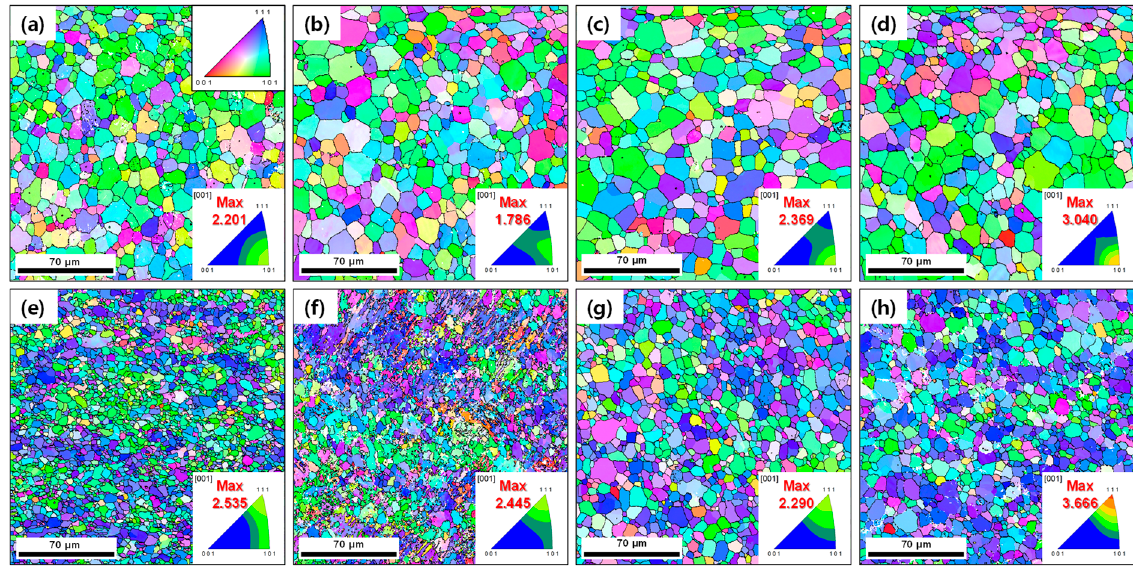
Figure 3. The IPF maps for the AR samples ( a ) annealed for 5 min at 873 K, ( b ) annealed for 5 min at 873 K and then aged at 523 K for 16 h, ( c ) annealed for 120 min at 873 K, ( d ) annealed for 120 min at 873 K and then aged at 523 K for 16 h. The IPF maps for the HRDSR samples ( e ) annealed for 5 min at 873 K, ( f ) annealed for 5 min at 873 K and then aged at 523 K for 16 h, ( g ) annealed for 120 min at 873 K, ( h ) annealed for 120 min at 873 K and then aged at 523 K for 16 h.